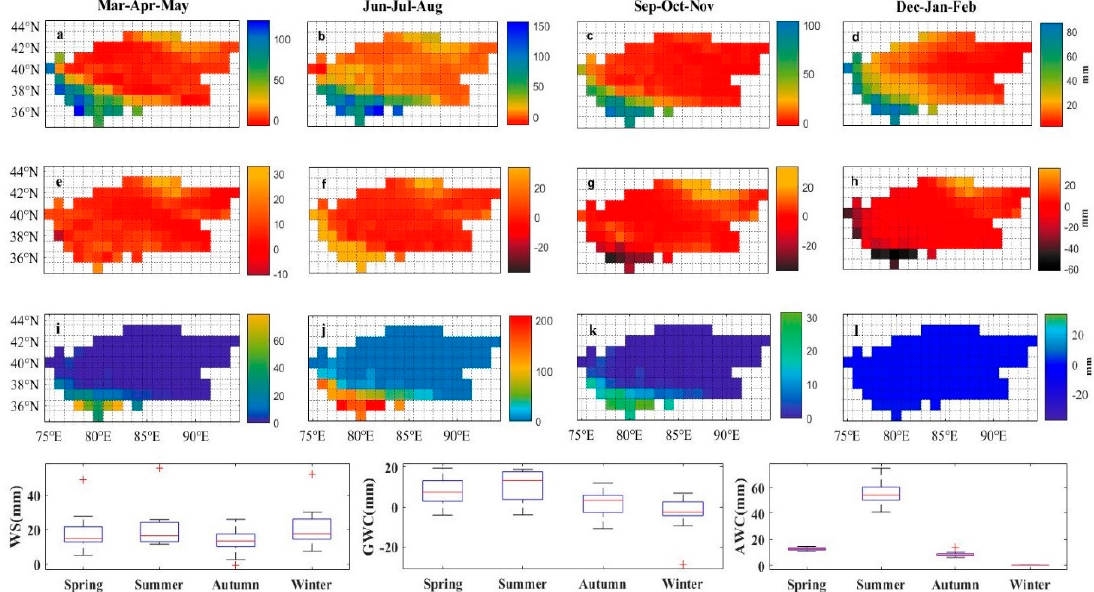
Figure 5. The seasonal patterns of WS, GWC, and AWC during 2002–2016. (( a – d ) are spring, summer, autumn, and winter WS patterns, respectively; ( e – h ) are spring, summer, autumn, and winter GWC patterns, respectively; ( i – l ) are spring, summer, autumn and winter AWC patterns, respectively; the last three figures are boxplots of the seasonal distribution of WS, GWC, and AWC at the 1° × 1° grid over the region, respectively).